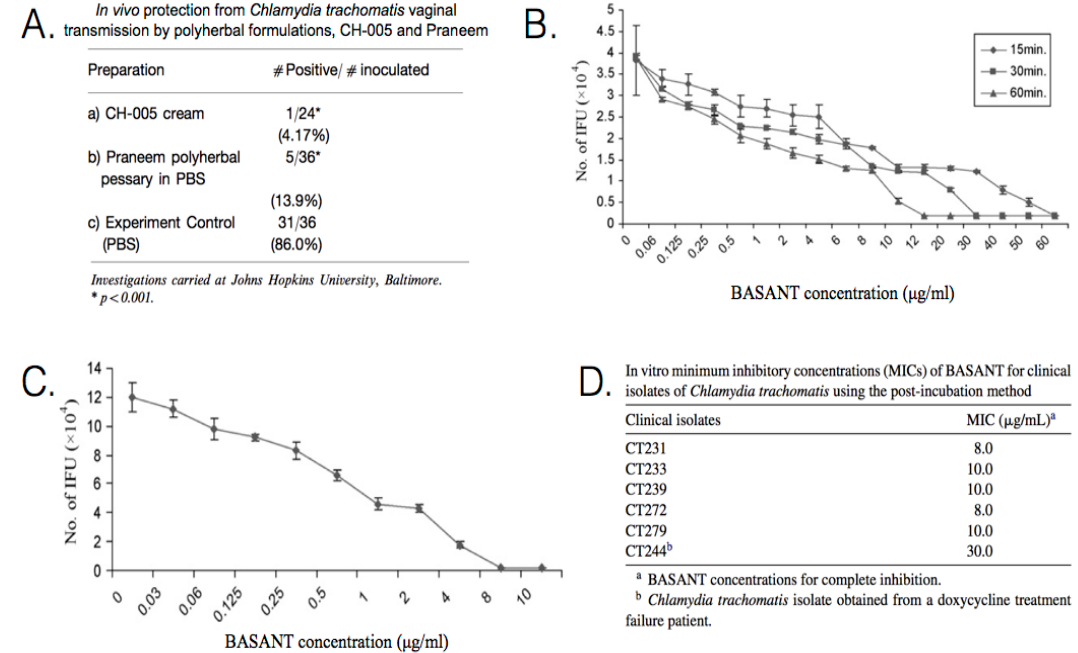
Figure 6. Efficacy of polyherbal formulations CH-005, Praneem, and BASANT. ( A ) In vivo protection from Chlamydia trachomatis vaginal transmission by polyherbal formulations CH-005 and Praneem; ( B ) Inhibitory effect of BASANT on C. trachomatis from pre-infection incubation. The number of inclusion-forming units (IFUs) decreases with incubation time and BASANT concentration; ( C ) Inhibitory effect of BASANT on C. trachomatis serovar D from post-infection incubation. The minimum inhibitory concentration (MIC) was determined to be 8 µ g/mL BASANT; ( D ) in vitro MICs of BASANT for clinical isolates of C. trachomatis from post-incubation incubation. Standard deviations from triplicate tests are indicated by error bars. Part A is adapted with permission from [91]. Copyright 2000 American Journal of Reproductive Immunology. Parts ( B – D ) are adapted with permission from [93]. Copyright 2008 International Society of Chemotherapy.